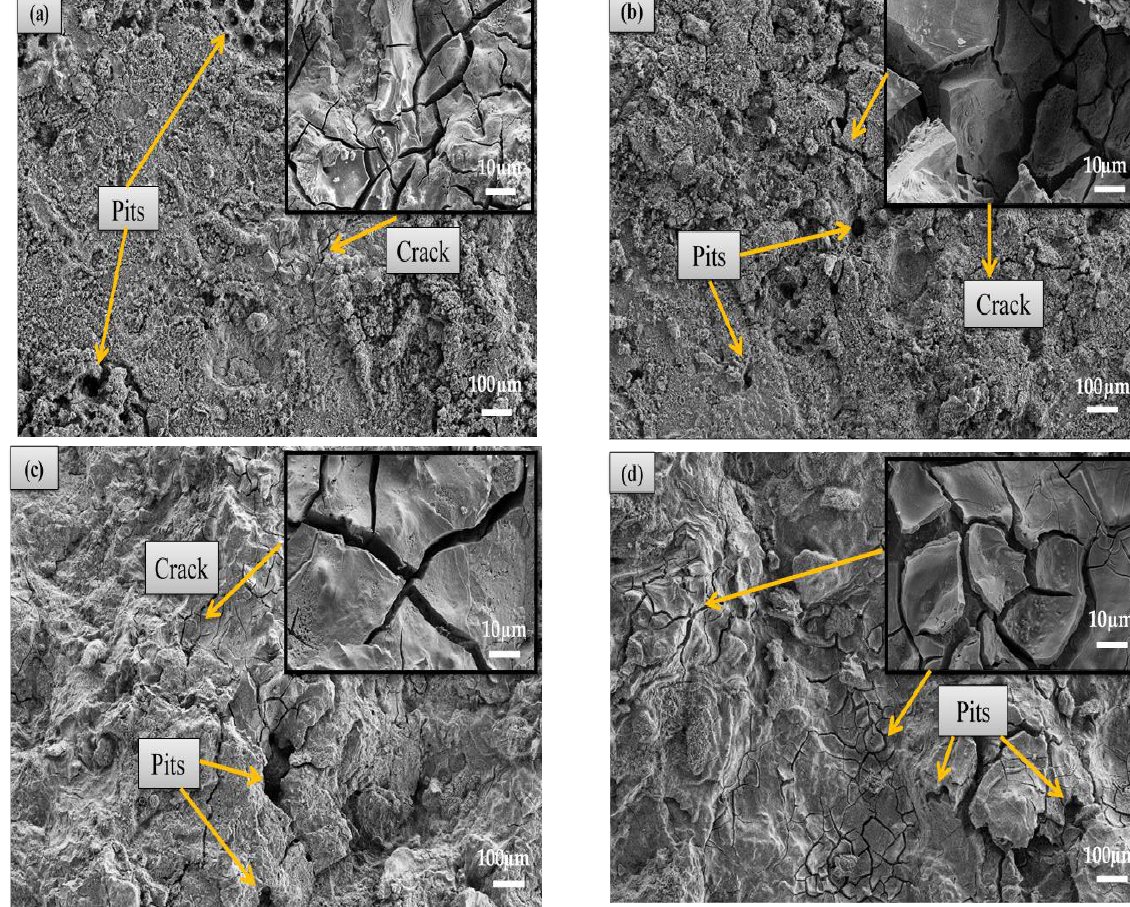
Figure 9. SEM Image Mg-Zn/HAP/ Al 2 O 3 for 2 h immersed in HBSS ( a ) 0 wt.% ( b ) 5 wt.% ( c ) 10 wt.% and ( d ) 15 wt.% Al 2 O 3 .